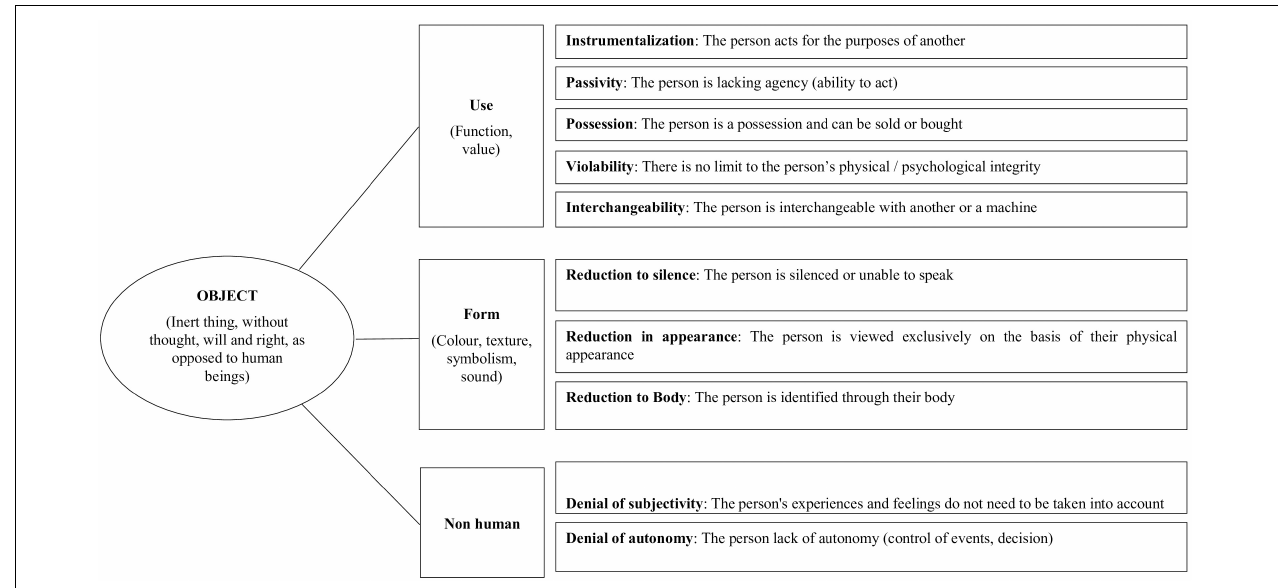
FIGURE 1 | Theoretical dimensions of